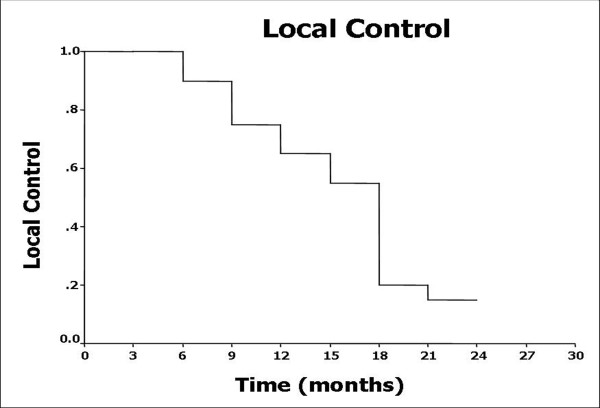
Local control curve after CT-guided 125I implantation.